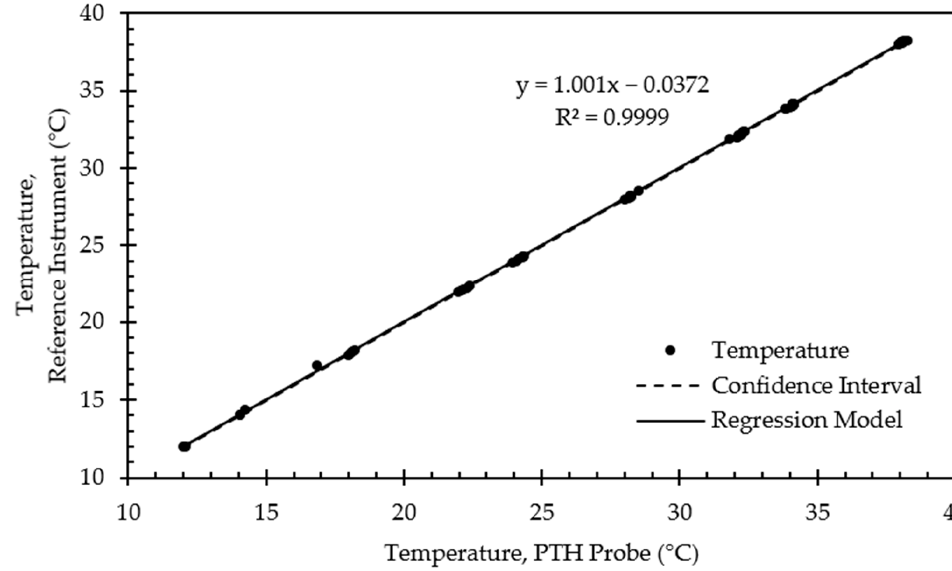
Figure 15. Regression model and corresponding confidence interval for temperature validation data from representative PTH probe (SN: 0x0005).